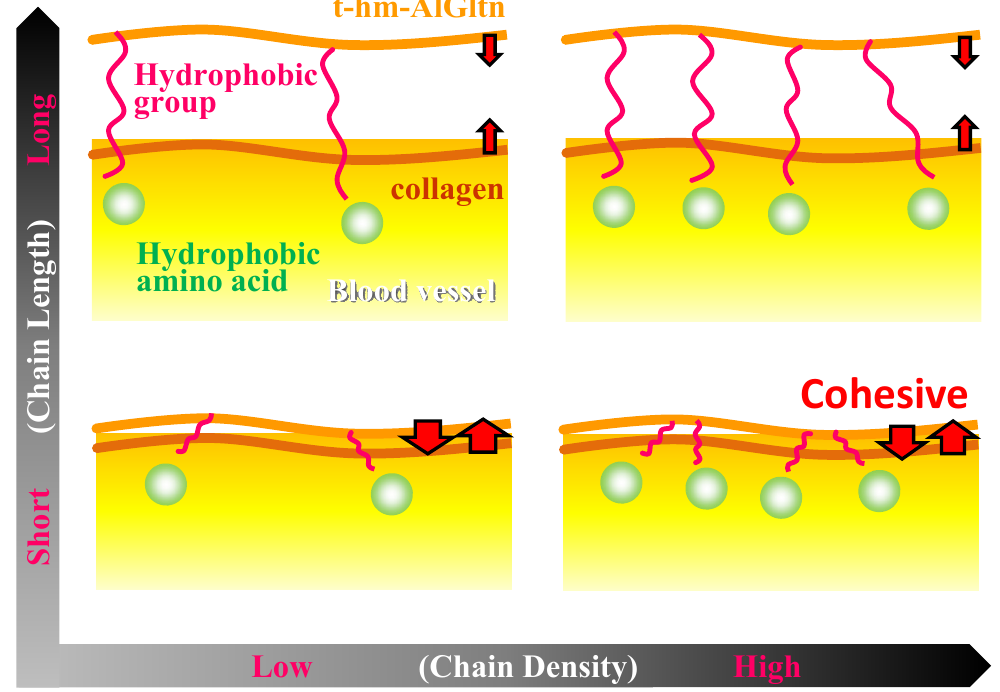
Figure 6. Schematic illustration of the bonding behavior of t-hm-AlGltns with various hydrophobic chain lengths and